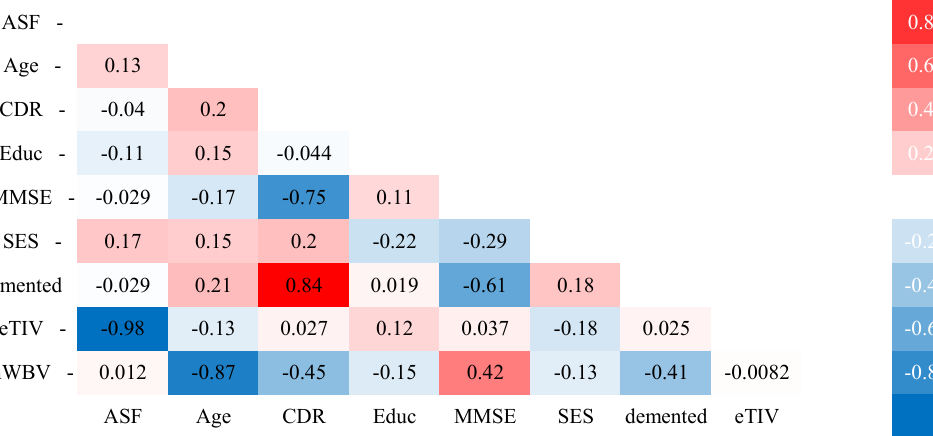
Figure 4. Correlation between features of the OASIS